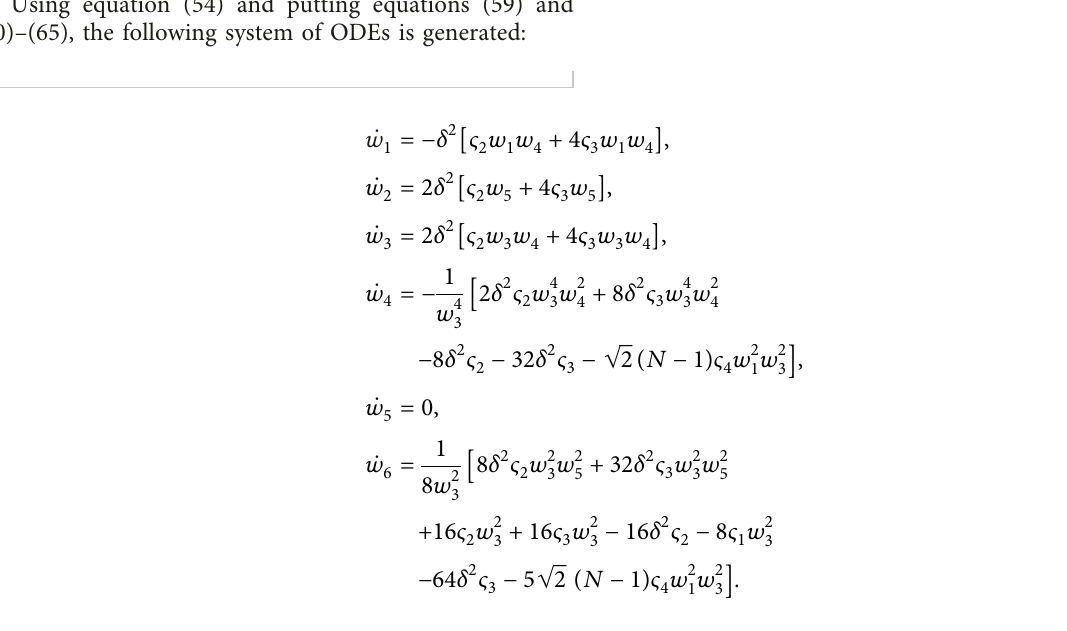
Figure 1: In these figures, we take ς solution | φ | 2 , (a) displays the 3D-plot of | φ | 2 with χ � 1, (b) displays the density plot of the solution | φ | 2 , and (c) displays the 2D-plot of | φ | 2 with different values of χ